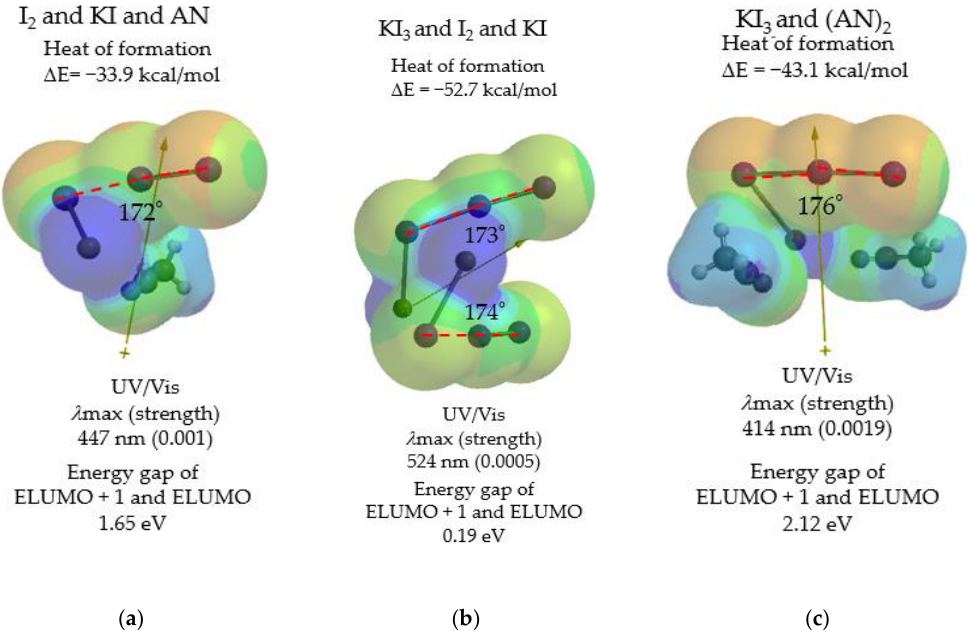
Figure 3. Equilibrium geometry of van der Waals aggregates and their heat of formation and Electrostatic potential map (ESPM) of energy structures: ( a ) I 2 and KI and AN; ( b ) KI 3 and I 2 and KI; ( c ) KI 3 and (AN) 2 .